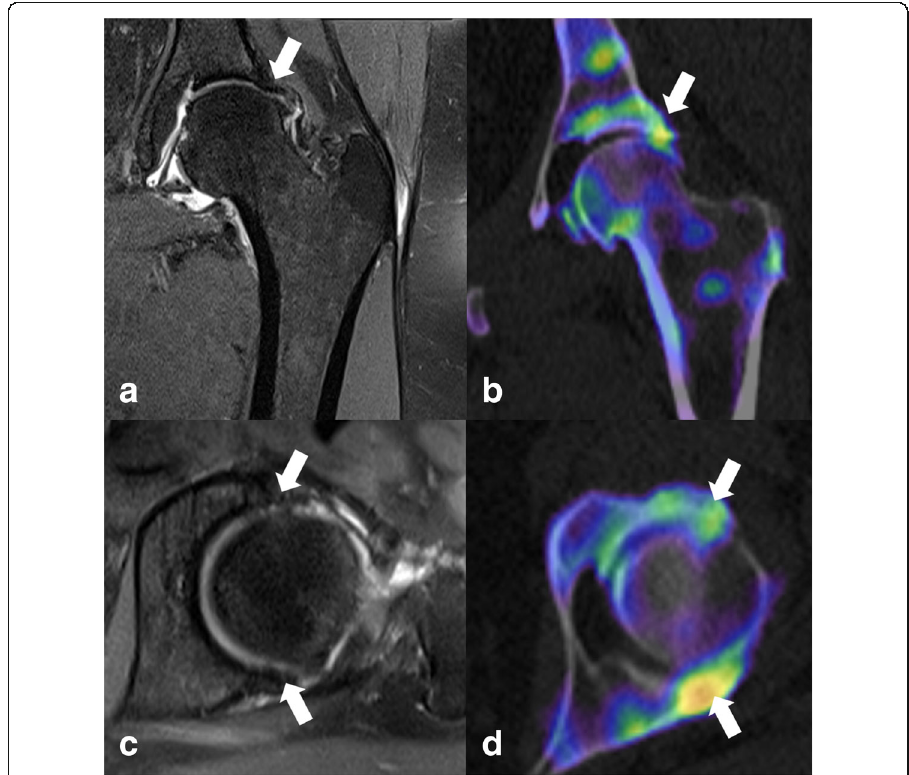
Fig. 6 MRI and xSPECT/CT of an osteoarthritic left hip. Detailed Legend: Corresponding slices from the same patient: a Coronal T2 fat suppressed image, b Coronal xSPECT-CT image, c Axial T2 fat suppressed image and d Axial xSPECT-CT images in the same patient. Thick arrows show cartilage loss (MRI) with corresponding adjacent bone changes